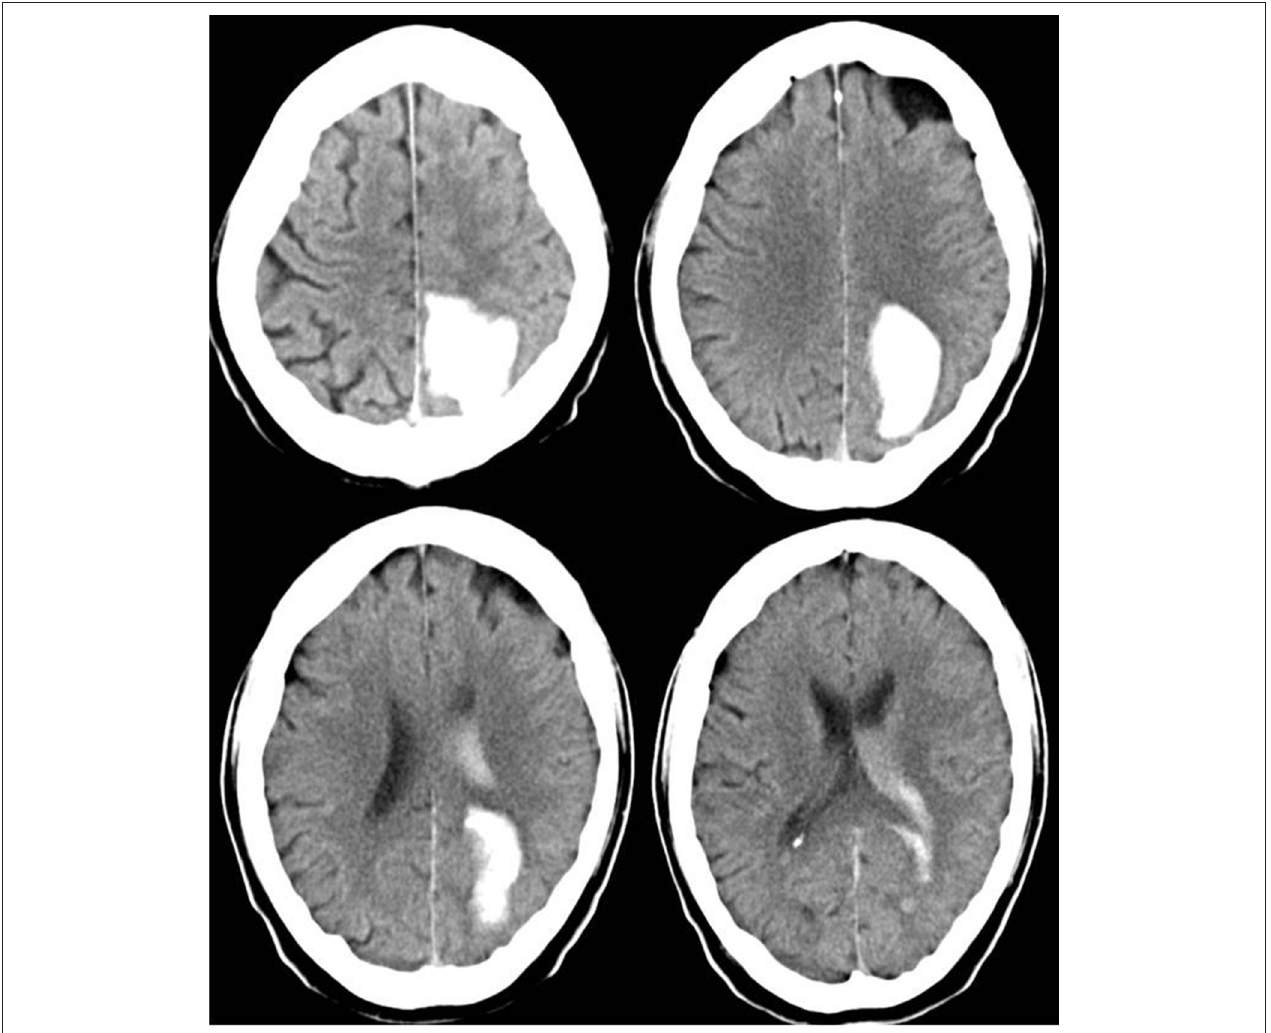
FIGURE 3 | cCT scan of a 63-year old man, acquired between 4.5 and 12h after symptom onset, showing left occipital ICH. Hemianopia to the left side resulted in a NIHSS score of 2 and in a GCS score of 15. The mean estimated NIHSS score was 11.2, the mean estimated GCS score